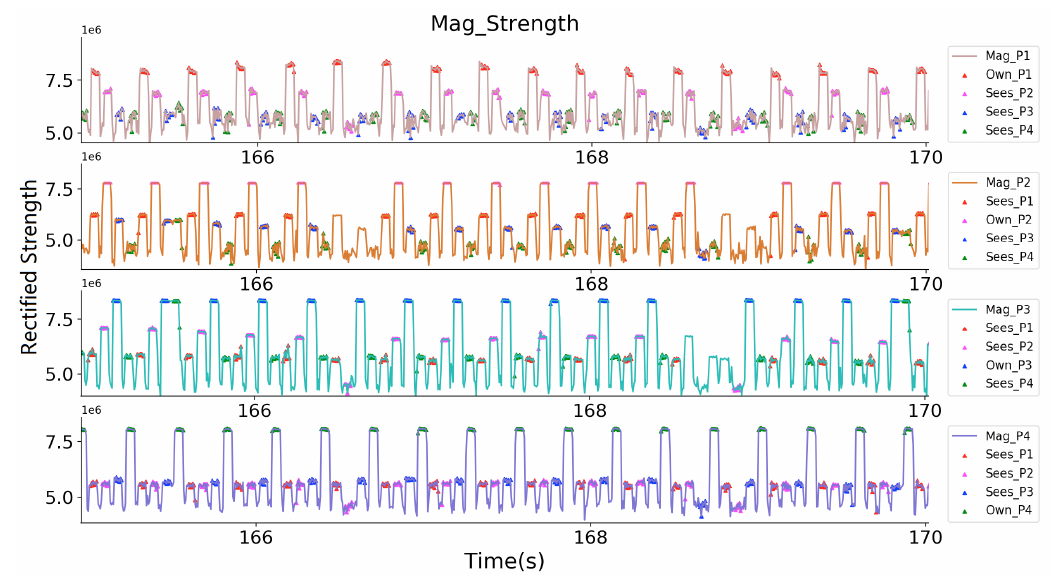
Figure 20. Four Volunteers’ receiver sampled rectified magnetic field strength signal, where they can see each